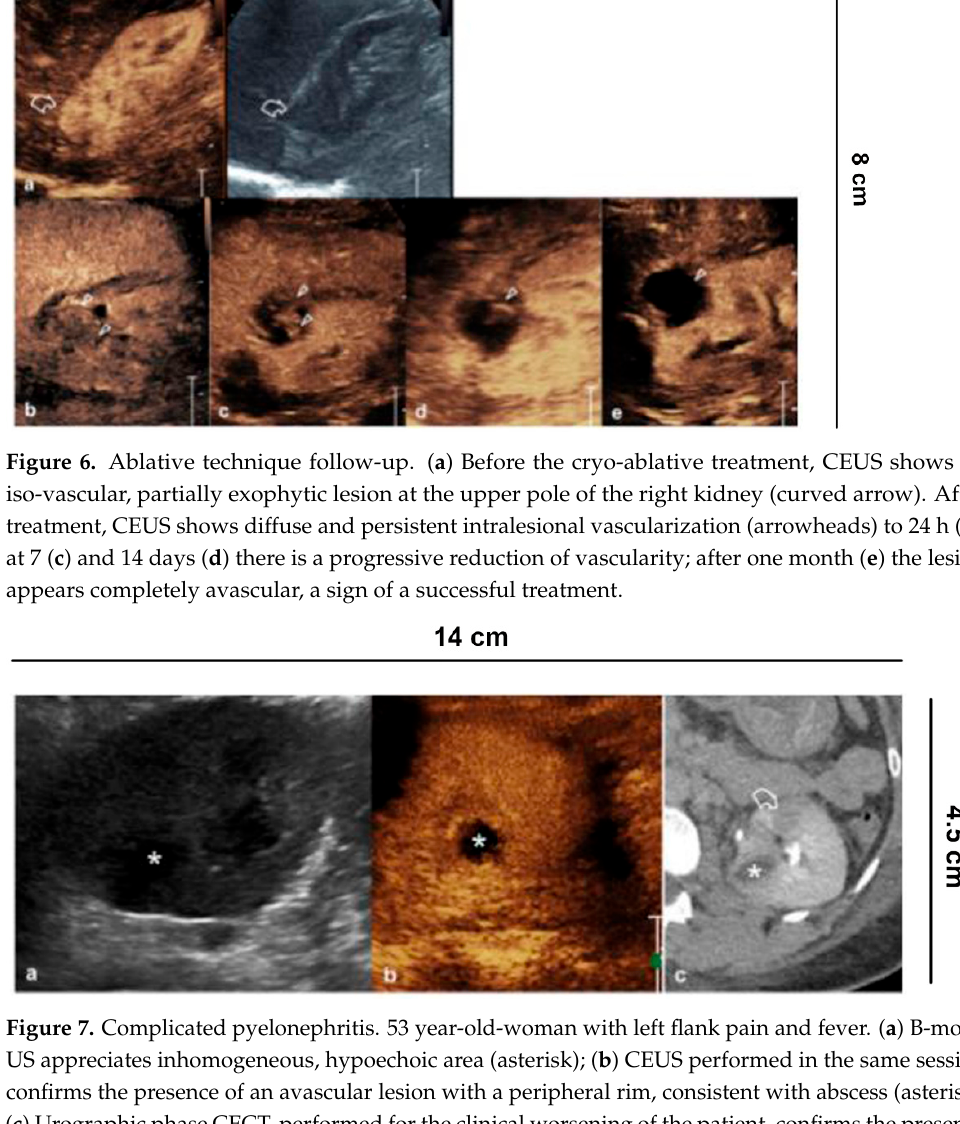
Figure 7. Complicated pyelonephritis. 53 year-old-woman with left flank pain and fever. ( a ) B-mode US appreciates inhomogeneous, hypoechoic area (asterisk); ( b ) CEUS performed in the same session confirms the presence of an avascular lesion with a peripheral rim, consistent with abscess (asterisk); ( c ) Urographic phase CECT, performed for the clinical worsening of the patient, confirms the presence of abscess (asterisk) and hypo-perfused area (curved arrow) at the lower pole of the kidney.